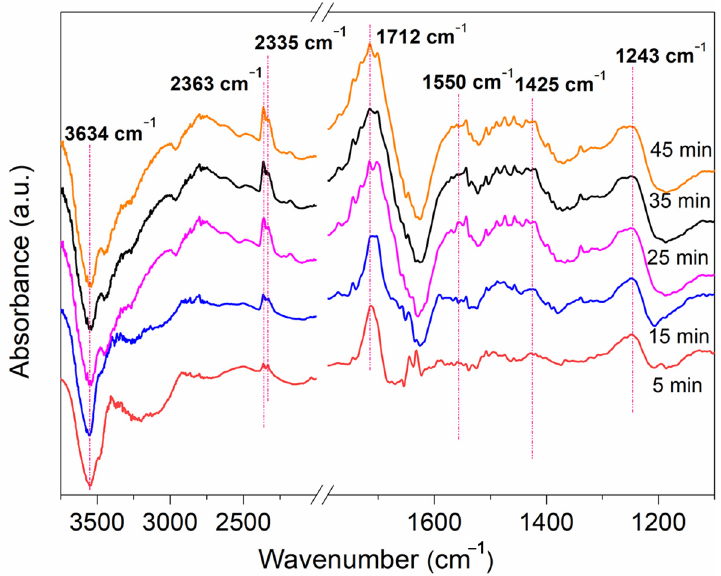
Figure 8. In situ DRIFTS of HCHO reaction on the catalyst MS/PDA/MnOx/GCN under xenon light irradiation.